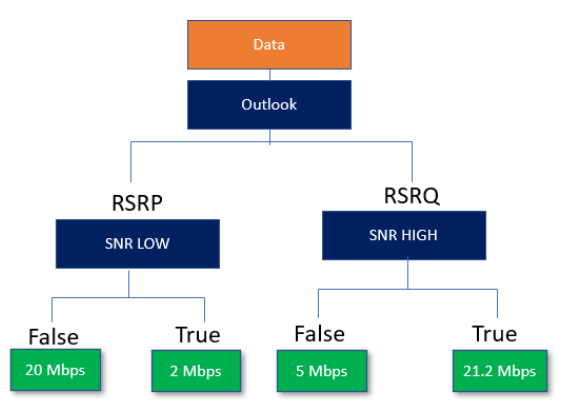
Figure 3. Representation of a